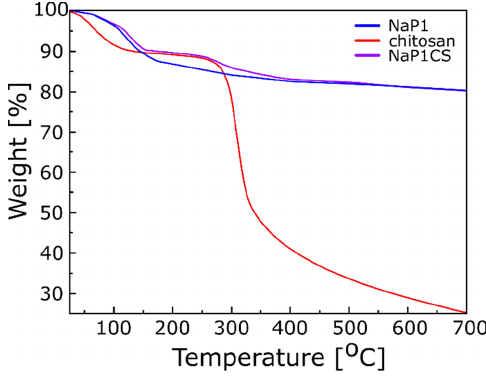
Figure 2. TG thermograms of chitosan, NaP1, and NaP1CS.